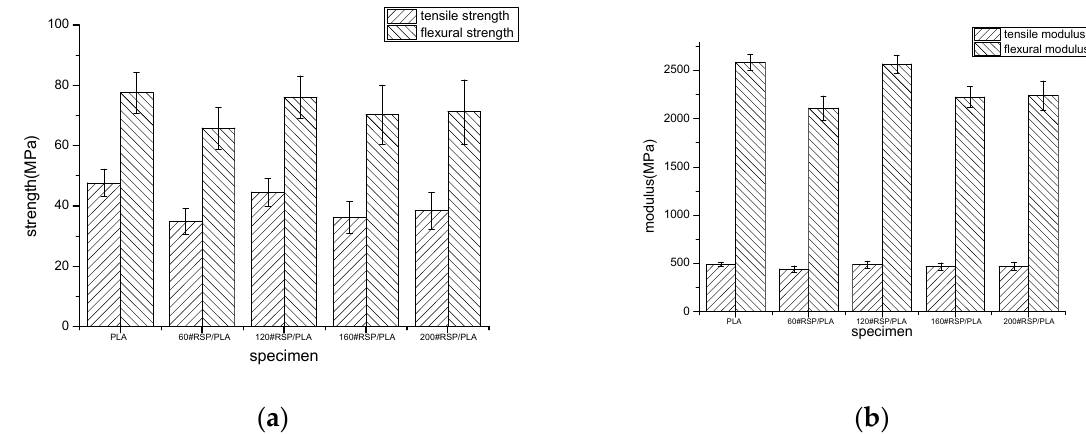
Figure 1. Mechanical properties of 3D-printed materials: ( a ) strength and ( b ) modulus.